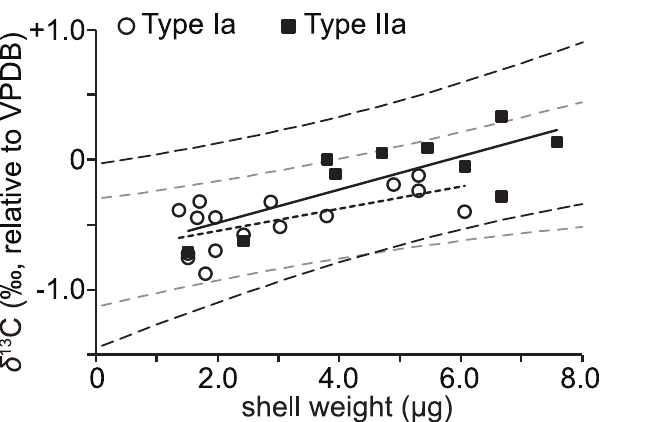
Fig 7. Changes in δ 13 C values in relation to shell weight in genetic types Ia and IIa of Globigerinoides ruber . Open circles correspond to type Ia and black squares to type IIa. Solid and dotted lines are the regression lines of types Ia and IIa, respectively. Black and gray dashed lines denote 95% confidence intervals for types Ia and IIa, respectively.